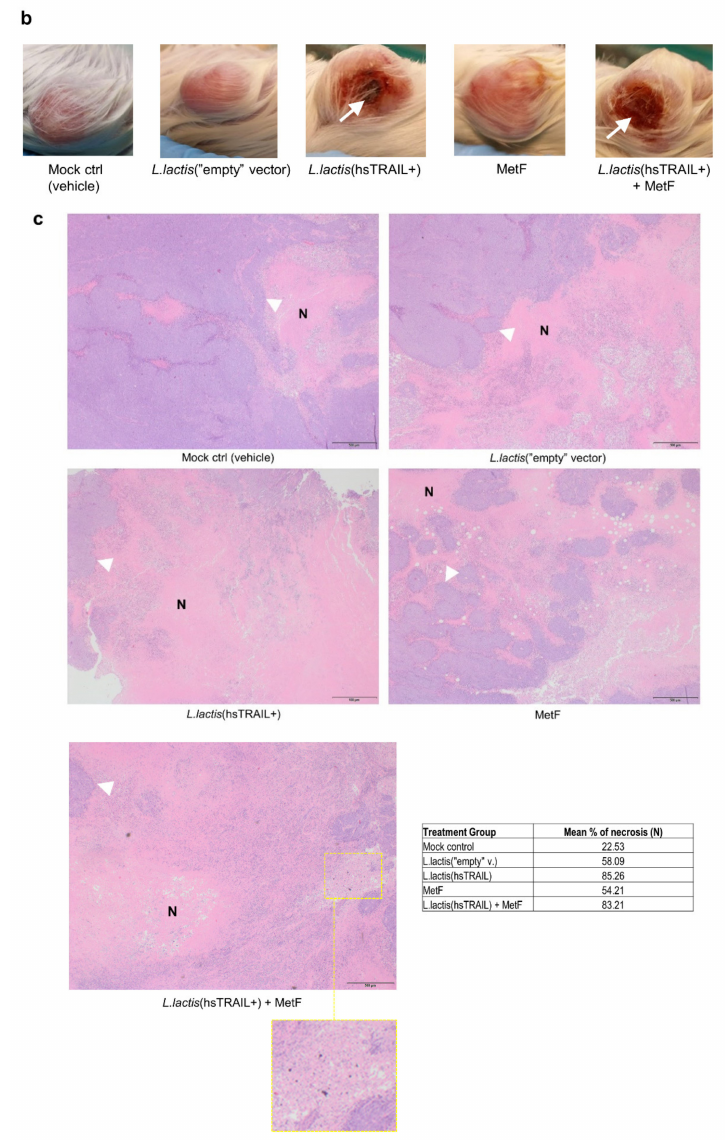
Figure 5. Anti-tumor activity of intratumorally administered L. lactis (hsTRAIL+) bacteria and MetF, given by gastric gavage: ( a ) Monitoring of the tumor size during the experiment. Tumor size was examined three times per week by external caliper measurements and calculated as described in Materials and Methods. Changes in the tumor size (y axis) are shown after normalization to the first day of the experiment (“Day 0”, designated as 100%). The arrows indicate time points of the treatment—each point indicates the mean value for n = 7 animals ± SEM. Statistical analysis was performed using two-way ANOVA test, with Tukey’s multiple comparisons post-hoc test. * p < 0.05, *** p < 0.001. Differences against the mock control group were marked in black, to the vector ctrl group was marked in grey; while comparison between MetF vs. co-tretament group or L. lactis (hsTRAIL+) vs. co-treatment group was marked in orange or green, respectively; ( b ) Macroscopical changes in subcutaneous HCT116-tumors after the treatments. The photos show representative tumors in animals from individual experimental groups, taken on day 19 of the experiment; ( c ) Histological analysis of subcutaneous tumors and quantification of the necrotic areas (H&E staining). Yellow dashed line denotes the area, which was further magnified to indicate the presence of cancer cells with condensed nuclei, characteristic for apoptosis (photo in the yellow frame). N—necrotic area; arrow—“border” of the viable tumor cells. Scale bar: 500 µ m. Table—results of the necrotic area quantification (for details see Materials and